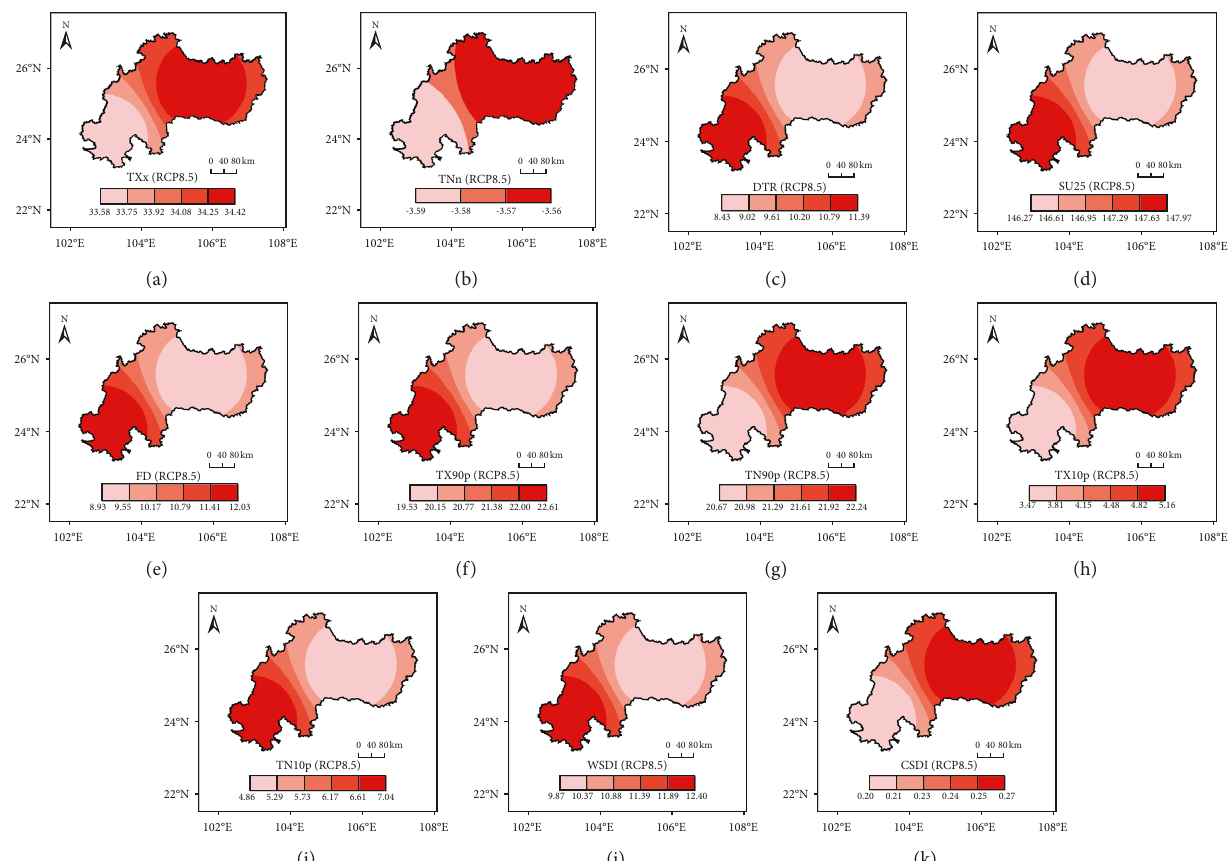
Figure 10: Spatial distribution of temperature extremes for 2021–2050 under